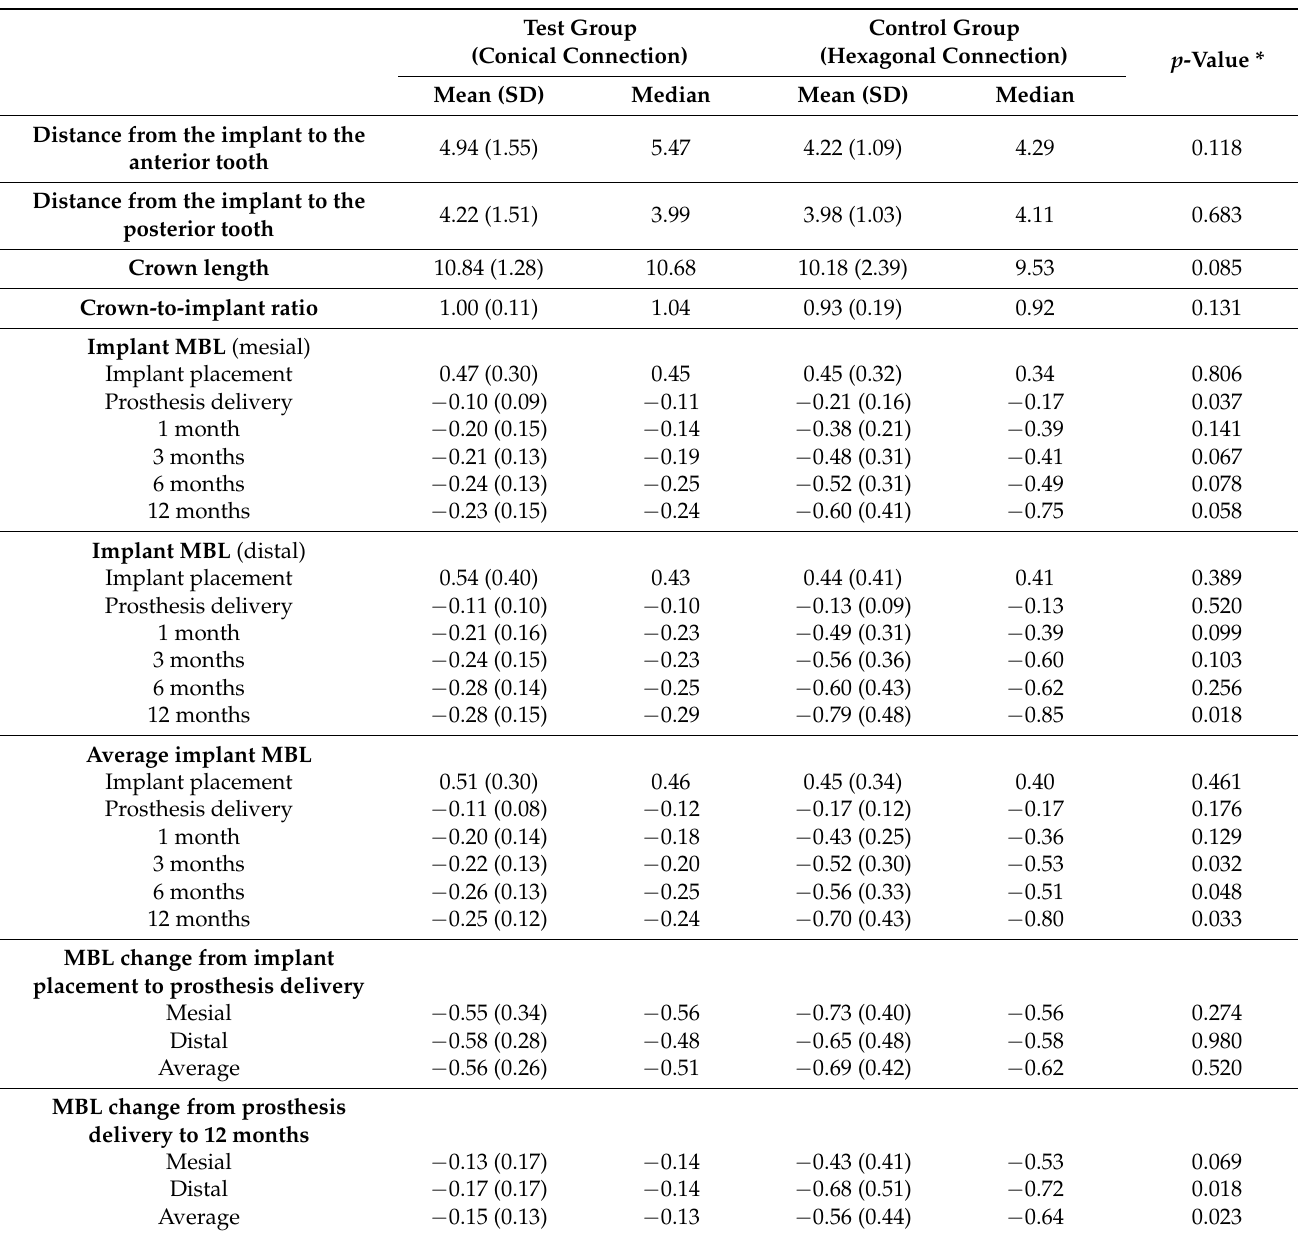
Table 2. Description and comparison of radiographical variables (in mm except for the crown-to-implant